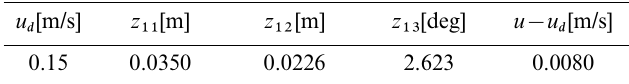
Table 5. Standard deviations for CyberShip II in the free-running manoeuvering